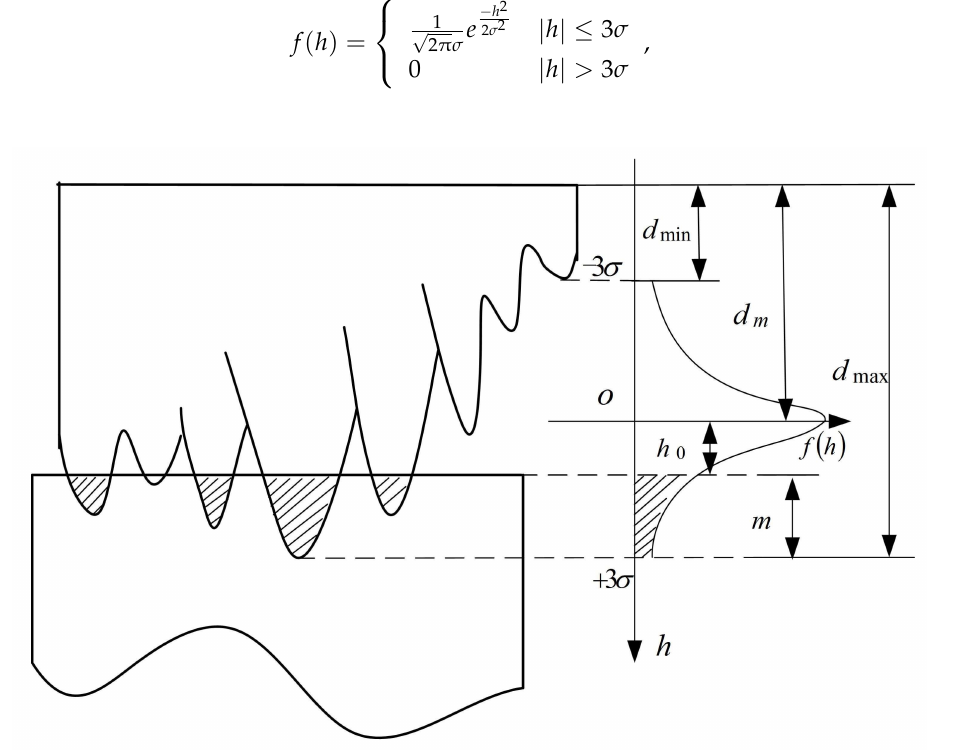
Figure 3. Schematic illustration of the abrasive grain heights